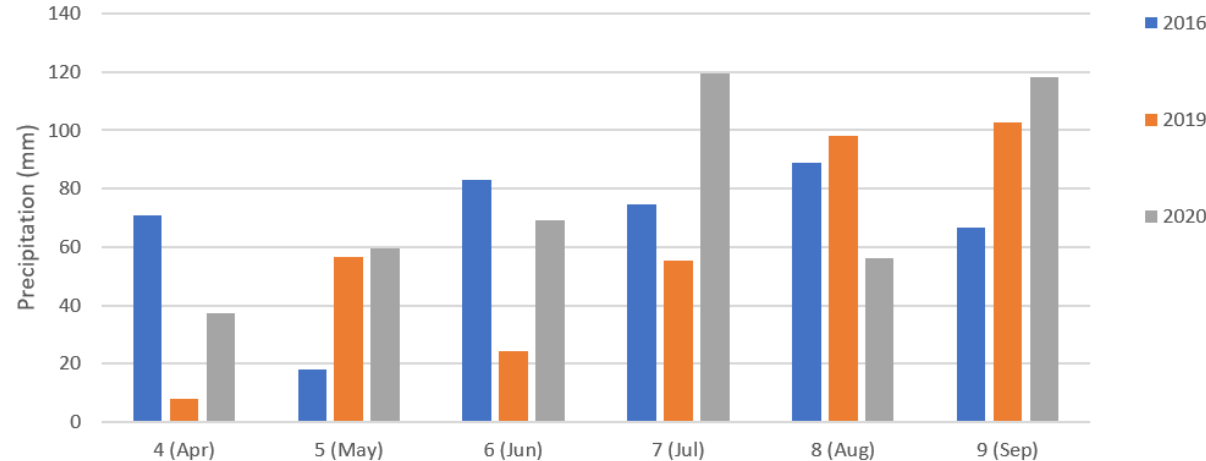
Figure A2. Monthly precipitation, provided by the Finnish meteorological Institute (FMI), from the nearest weather station to research fields i3 and i4 (Siuntio Sjundby). Data were visualized from the main growing season (April – September) during the years of drone data collection (2016, 2019, and 2020).